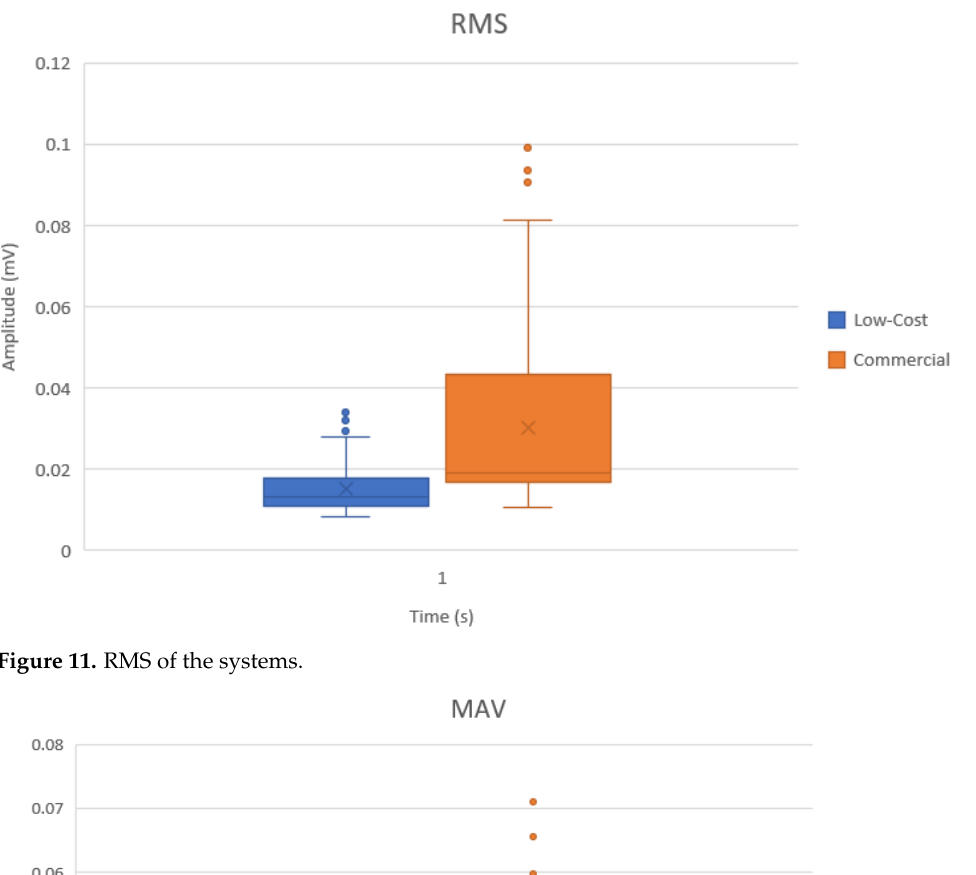
Figure 11. RMS of the systems.